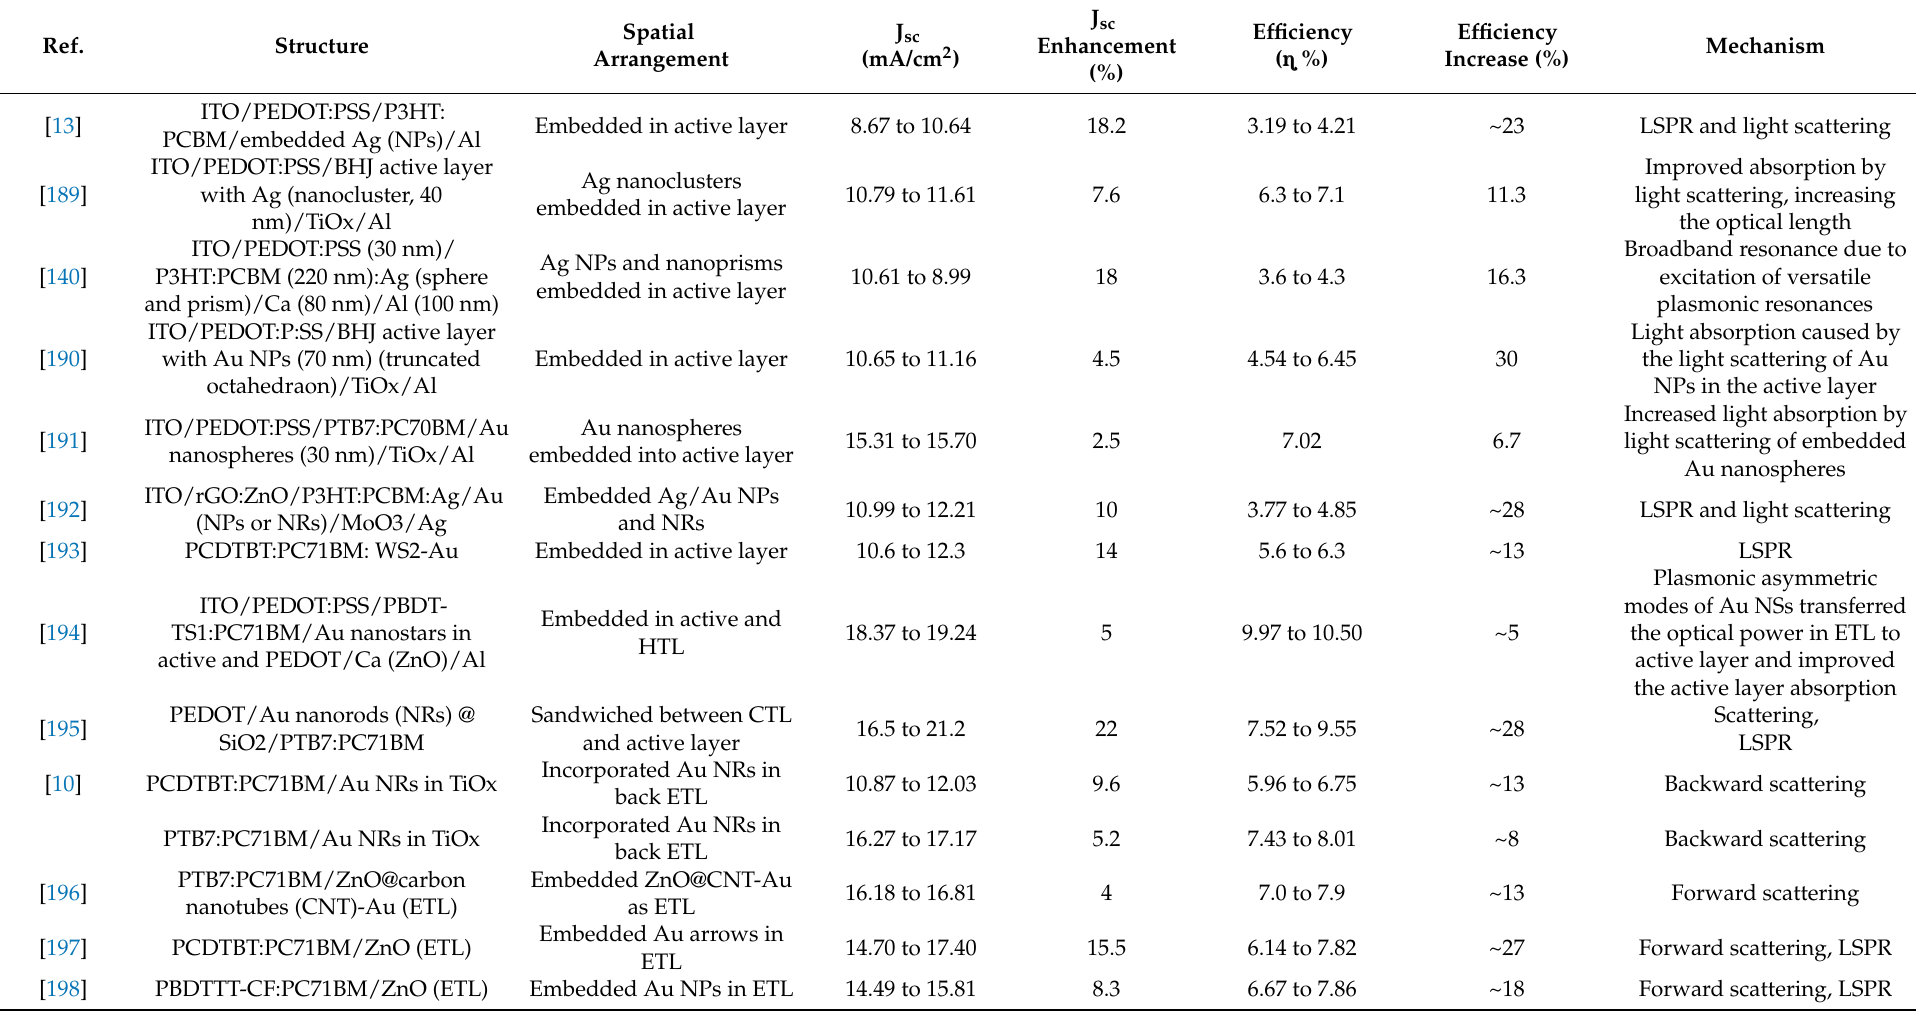
Table 1. Summary of plasmonic nanoparticle applications in organic solar cells and effects on cell performance.